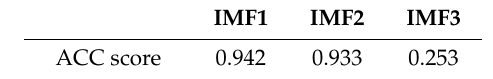
Table 3. Average classification accuracy (ACC) scores of related IMFs